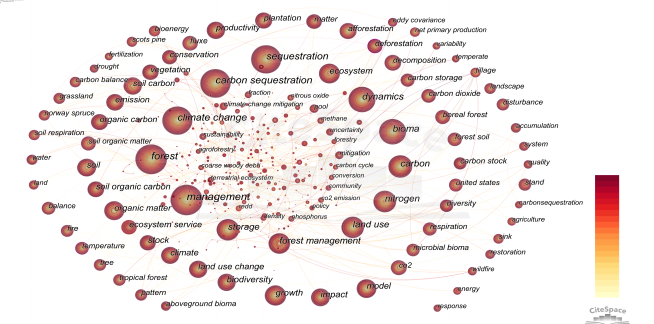
Figure 11. Keyword co-occurrence mapping for forest management research in the context of carbon neutrality from 2002 to